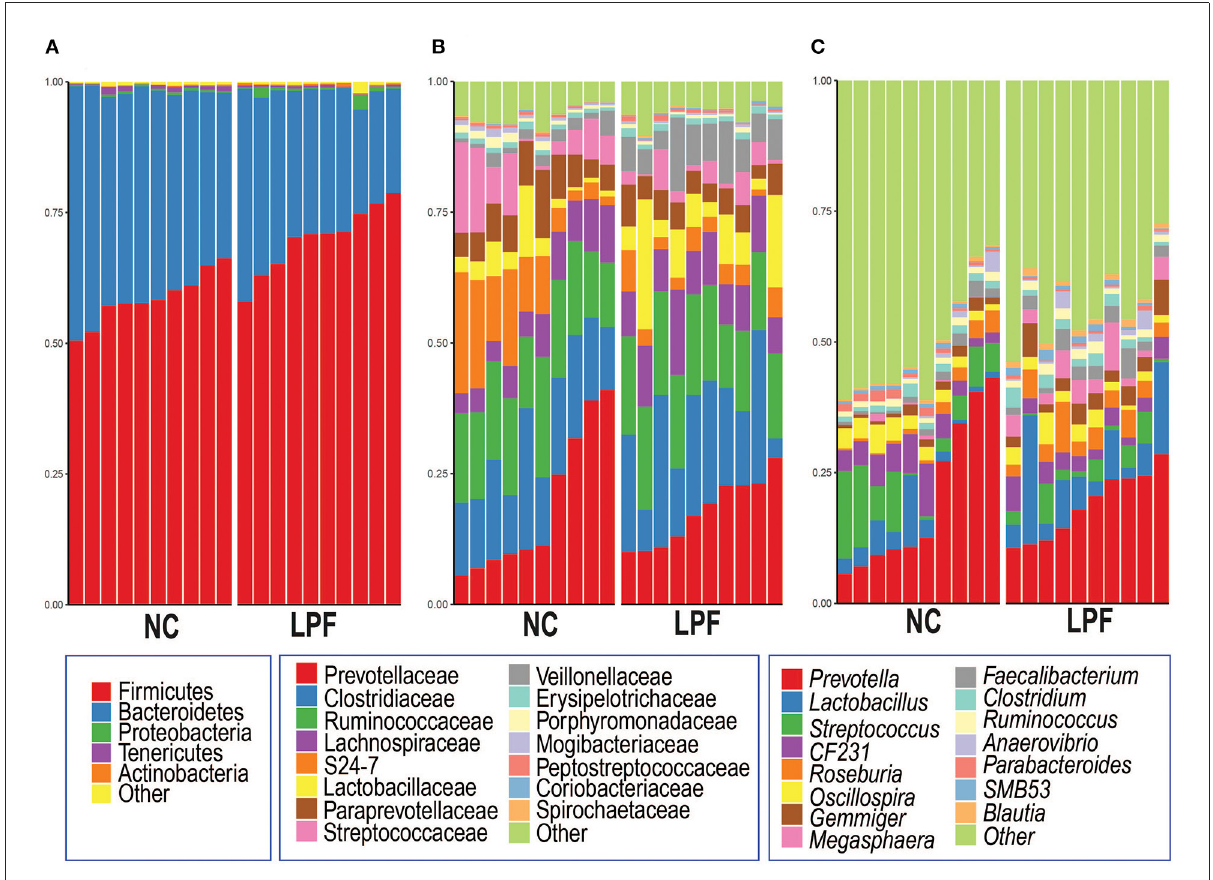
FIGURE3 Gut microbiota compositions at (A) phylum, (B) family, and (C) genus levels for each treatment. NC diet: basal diet, LPF diet: NC + 10% Lactobacillus plantarum and Pediococcus acidilactici co-fermented feed.